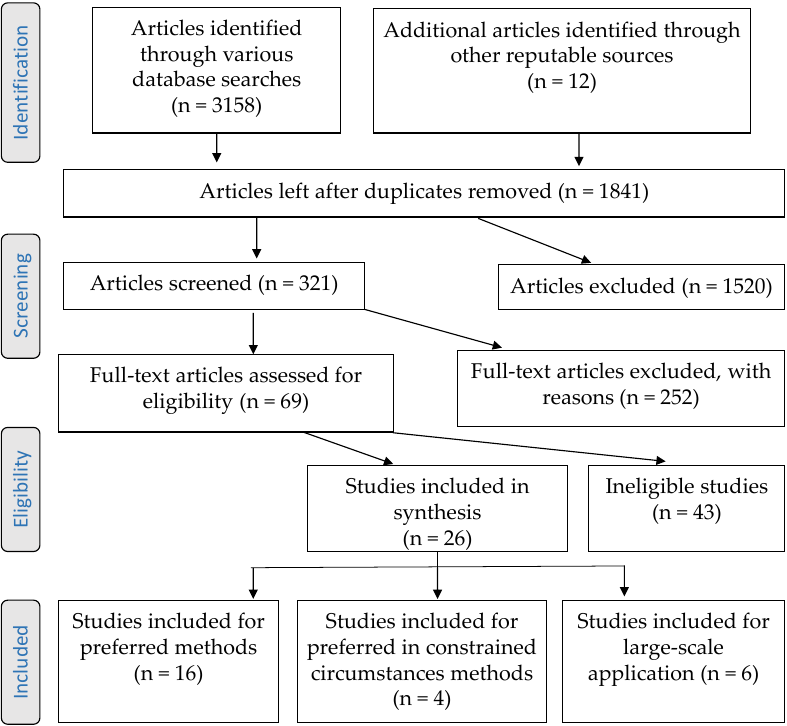
Figure 1. Summary of the literature searching and screening process using the Preferred Reporting Items for Systematic reviews and Meta-Analysis (PRISMA) checklist flow diagram. Table 1. List of preferred swine depopulation methods as well as those permitted in constrained circumstances.